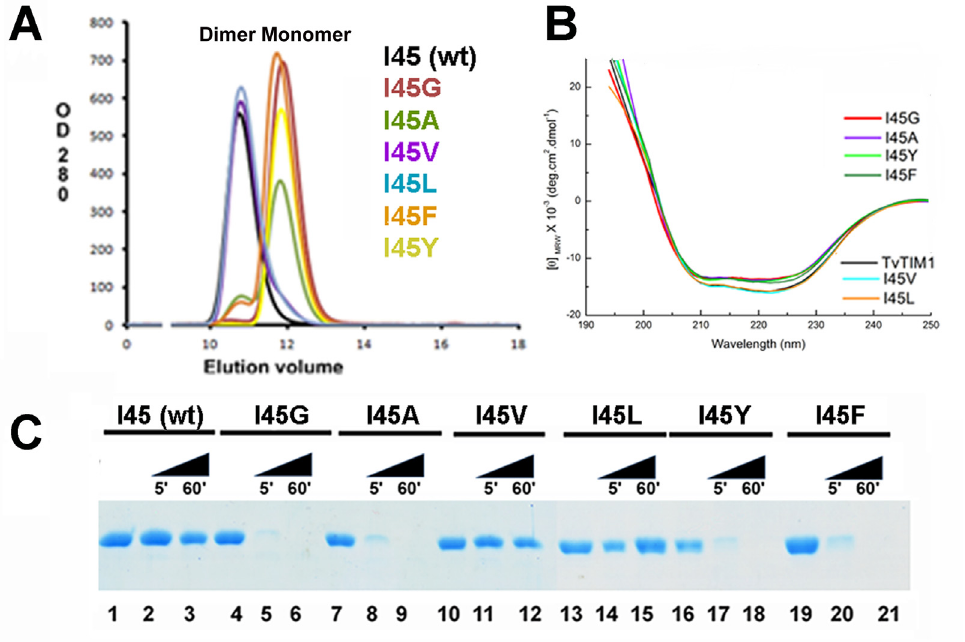
Fig 2. The identity of residue 45 determines the dimer-monomer equilibrium of TvTIM1. (A) Gel filtration elution profiles of wild-type and residue 45 point mutants. Mutants I45G, I45V, I45F and I45Y present as a monomer, whereas I45V and I45L as dimer. Mutant I45G and I45A present a small peak (6 and 3% of the total protein respectively) at the retention time of the dimer indicating that both mutants at a concentration of 260 μ M exist in dimer-monomer equilibrium. (B) CD spectra of wild type and I45 mutants. The spectra of I45L and I45V superimpose with the wild-type spectra, whereas monomeric constructs present a decrease on ellipticity. (C) Partial proteolysis of TvTIM1 mutants. SDS-PAGE showing the digestion patterns of digested proteins after a partial proteolysis experiment (5 and 60 minutes). At 5 minutes almost the totality of the monomeric proteins I45G, I45V, I45F and I45Y are digested by trypsin, and after 60 minutes the digestion is complete. In contrast a strong protein band is observed for wild-type and of I45L and I45V mutants indicating that dimeric enzymes present an increased resistance to